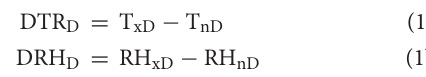
ecozones, regional zones, agricultural regions and boreal forest, with 50-km radius circles around each